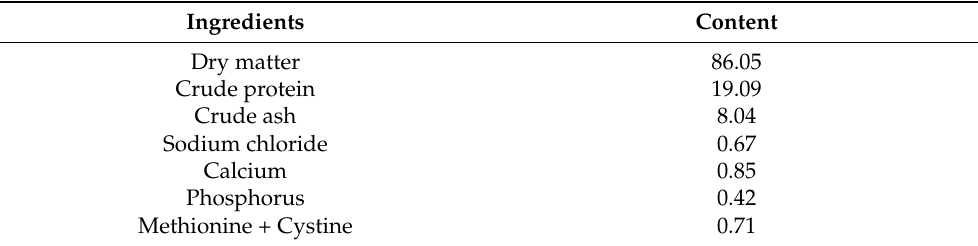
Table 1. Ingredients and composition of basal diet (%, dry matter basis).